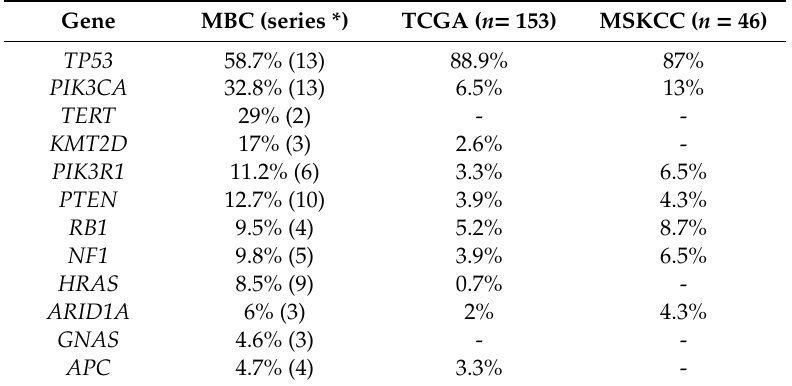
Table 1. Comparison of mutations of metaplastic breast carcinoma (MBC) compared with invasive ductal carcinoma (IDC)